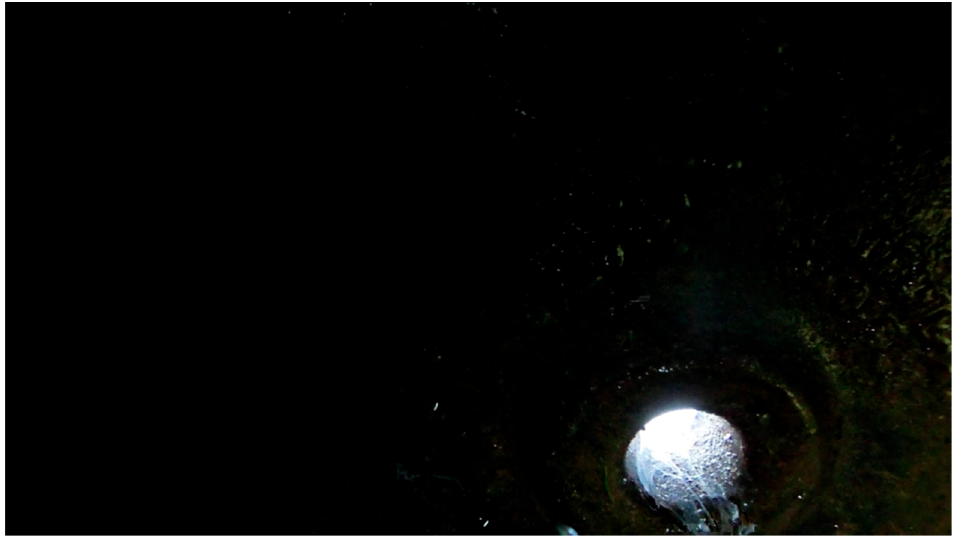
Figure 8. Downward vertical movement of ‘smoke’ through the opening in the manhole cover.